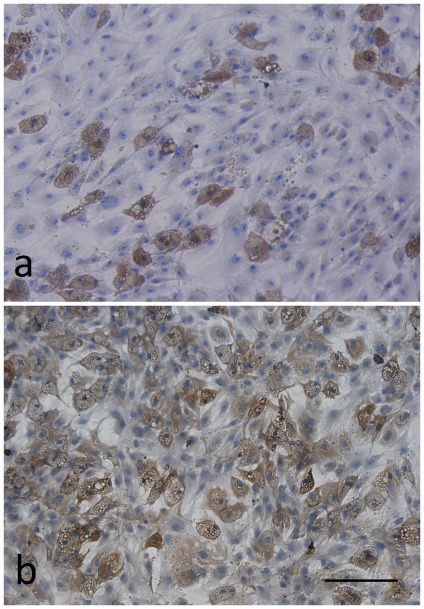
The expression of leptin receptor in induced adipocytes was determined by immunocytochemistry.The AIS MSCs (a) was from a 14-year-old boy (Cobb angle = 80°) and the normal control (b) was from a 19-year-old boy. Note that the leptin receptors were abundant in undifferentiated MSCs from control sample, but were rare in those from AIS sample. Scale bar = 200 µm.